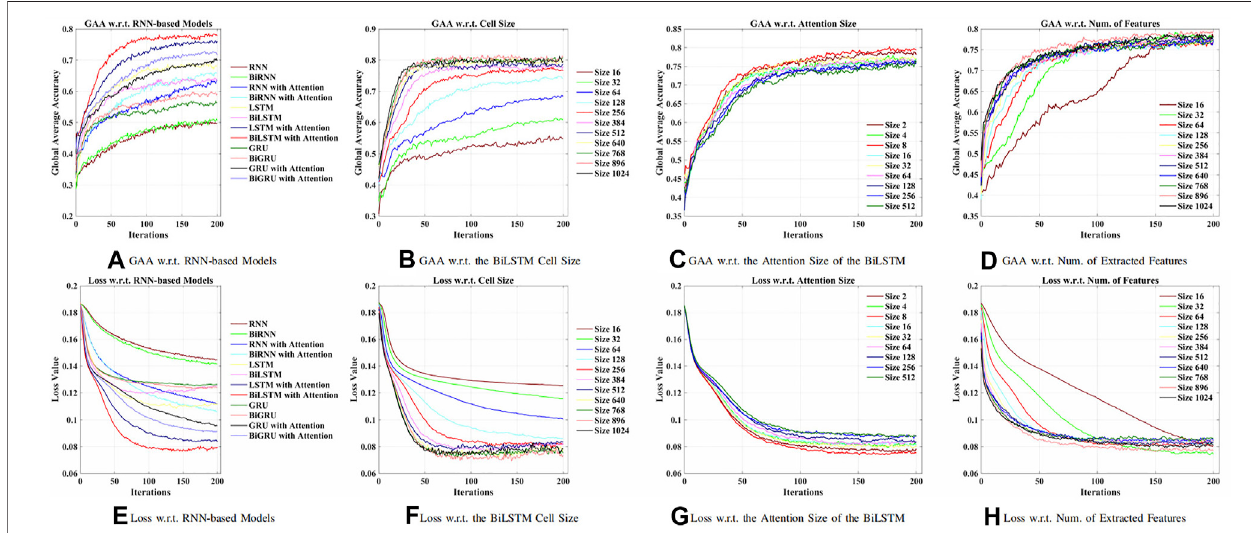
FIGURE 4 | Comparison of models and hyperparameters w.r.t. the recurrent neural network (RNN)-based methods for feature extraction. (A) Global average accuracy (GAA) w.r.t. RNN-based models. (B) GAA w.r.t. BiLSTM cell size. (C) GAA w.r.t. attention size of the BiLSTM. (D) GAA w.r.t. the number of the extracted features. (E) Loss w.r.t. RNN-based models. (F) Loss w.r.t. BiLSTM cell size. (G) Loss w.r.t. attention size of the BiLSTM. (H) Loss w.r.t. the number of the extracted